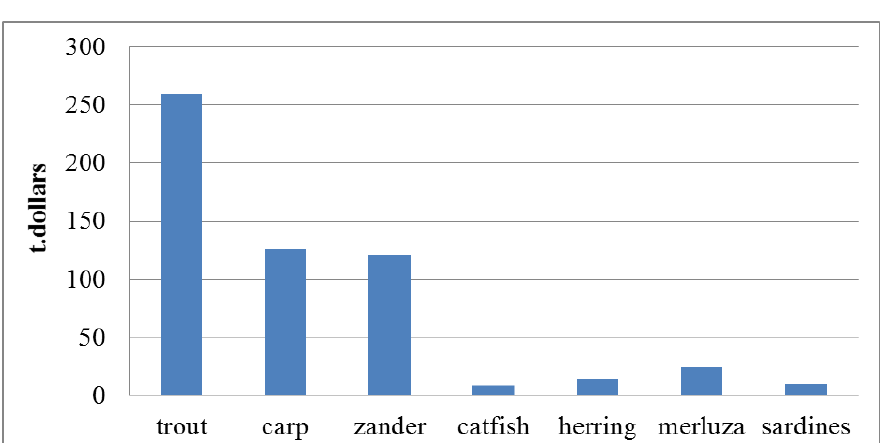
Fig. 5. The export of frozen fish of Ukraine in 2018, ths